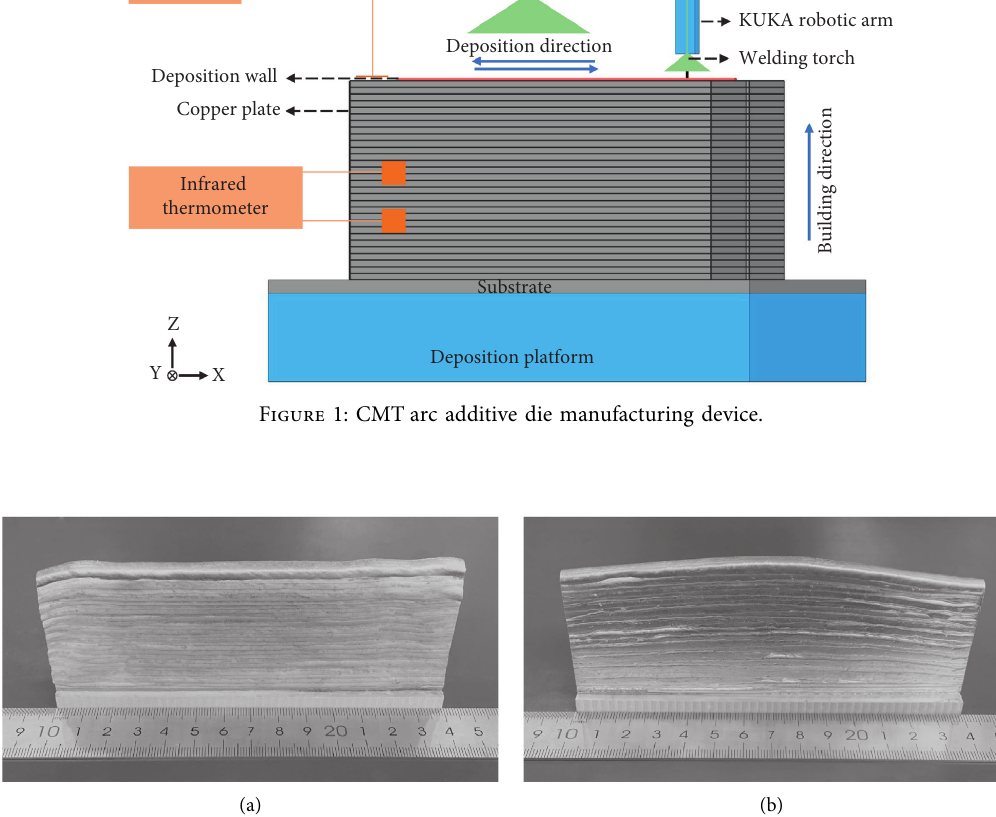
Figure 2: Shape and size of the deposition wall (a) without path restriction and (b) with the copper plates constrained path.